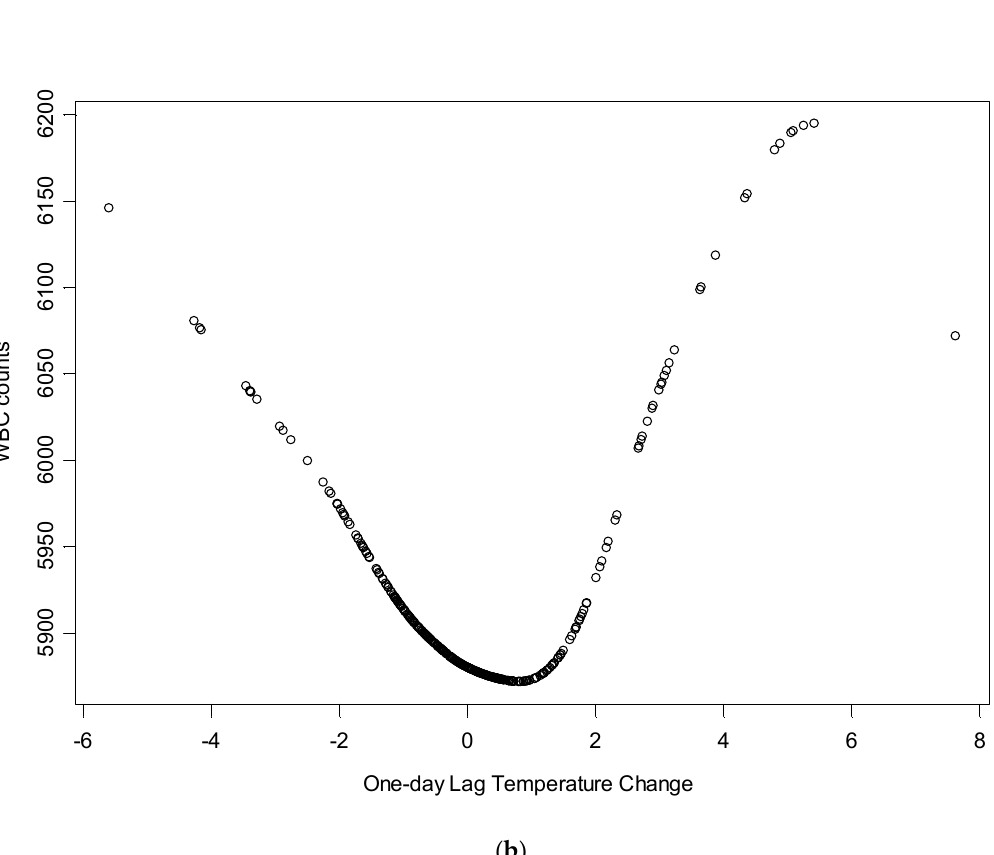
Figure 3. ( a ) Scatter plot of total WBC counts by one-day lag temperature with trend line of generalized additive model (GAM) procedure. The p -value of the GAM analysis is 0.000154; ( b ) zoom in the trend line at the central area.